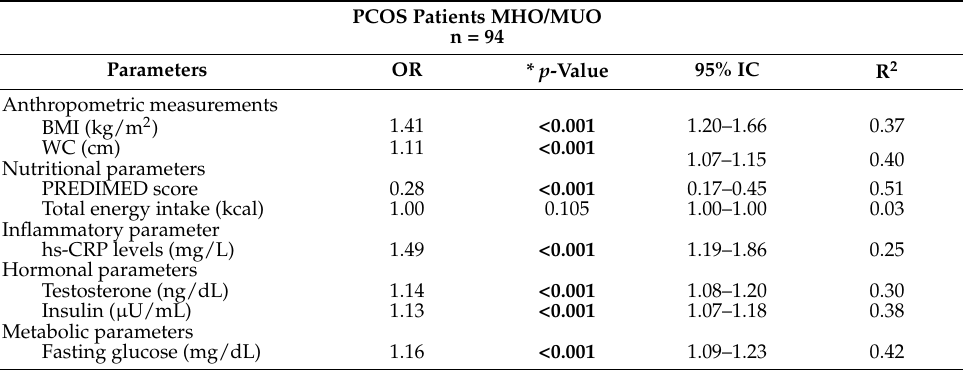
Table 5. Bivariate OR model to assess the association of PCOS patients MHO/MUO with all continu- ous variables including in this